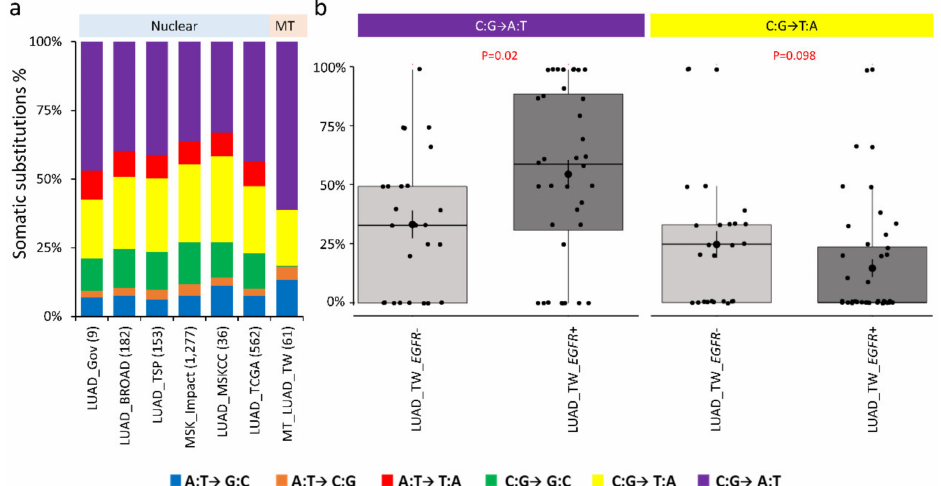
Figure 4. Comparison of nucleotide substitutions. ( a ) Comparison of somatic nucleotide substitution profiles of nuclear genomes from various studies and mitochondrial genomes. ( b ) Distribution of C to T transitions (G to A) and C to A (G to T) transversions among patients with and without EGFR -activation